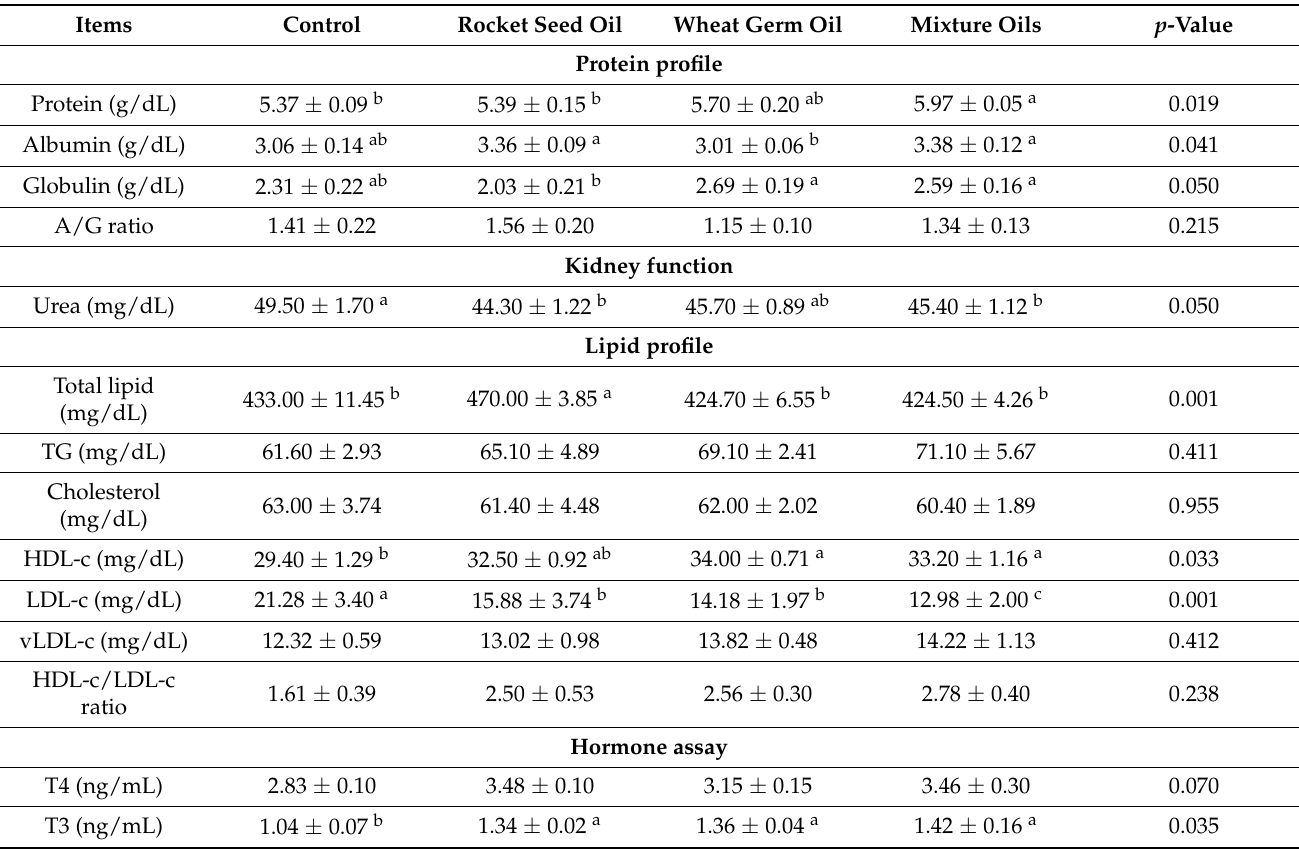
Table 5. Serum biochemical constituents of V-line growing rabbits (5–12 weeks of age) that were administered orally with rocket seed oil, wheat germ oil, and their